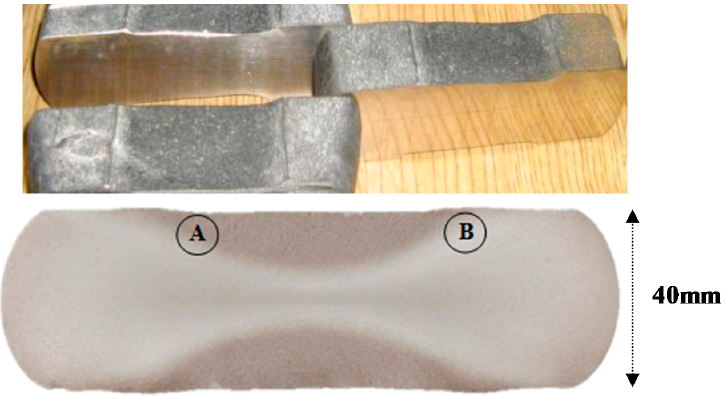
Figure 1. Cuts and macro-etched image of the deformed sample; specimens from the A and B regions were sectioned from the sample to perform the delta-processing treatment (DP718).